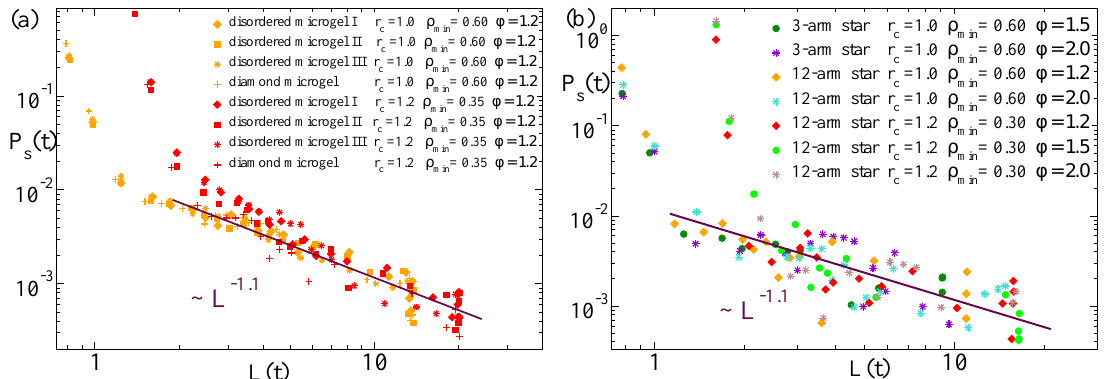
Figure 9. Domain self-correlation function P s ( t ) vs. domain size L ( t ) at the time t during the collapse, for several values of the solvent quality parameter φ and the parameters ( r c , ρ min ) defining the density field (see legends). Panel ( a ) shows data for the diamond microgel and three disordered microgels. Panel ( b ) shows data for the three-arm and 12-arm stars. The lines in both panels fit to a power-law P s ∼ L − 1.1